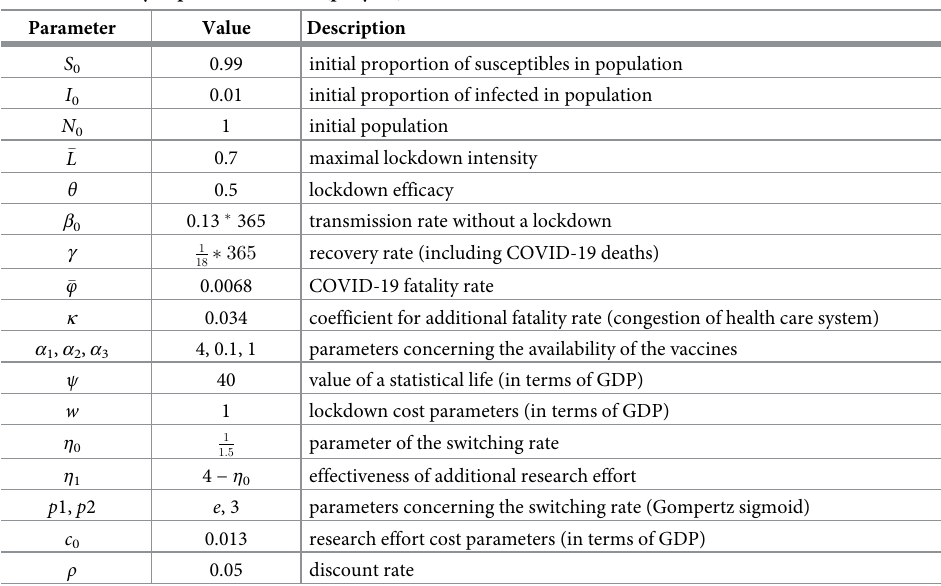
Table 2. Summary of parameter values (per